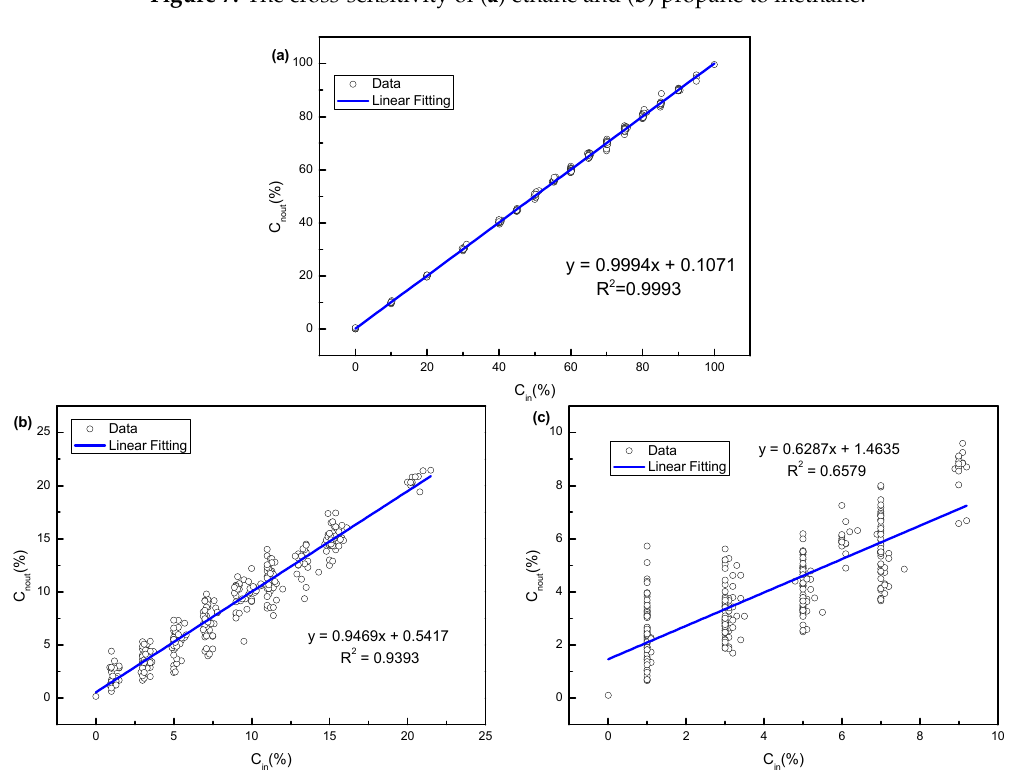
Figure 8. Results of the MLP NN algorithm for the recognition of ( a ) methane, ( b ) ethane and ( c ) propane, respectively.